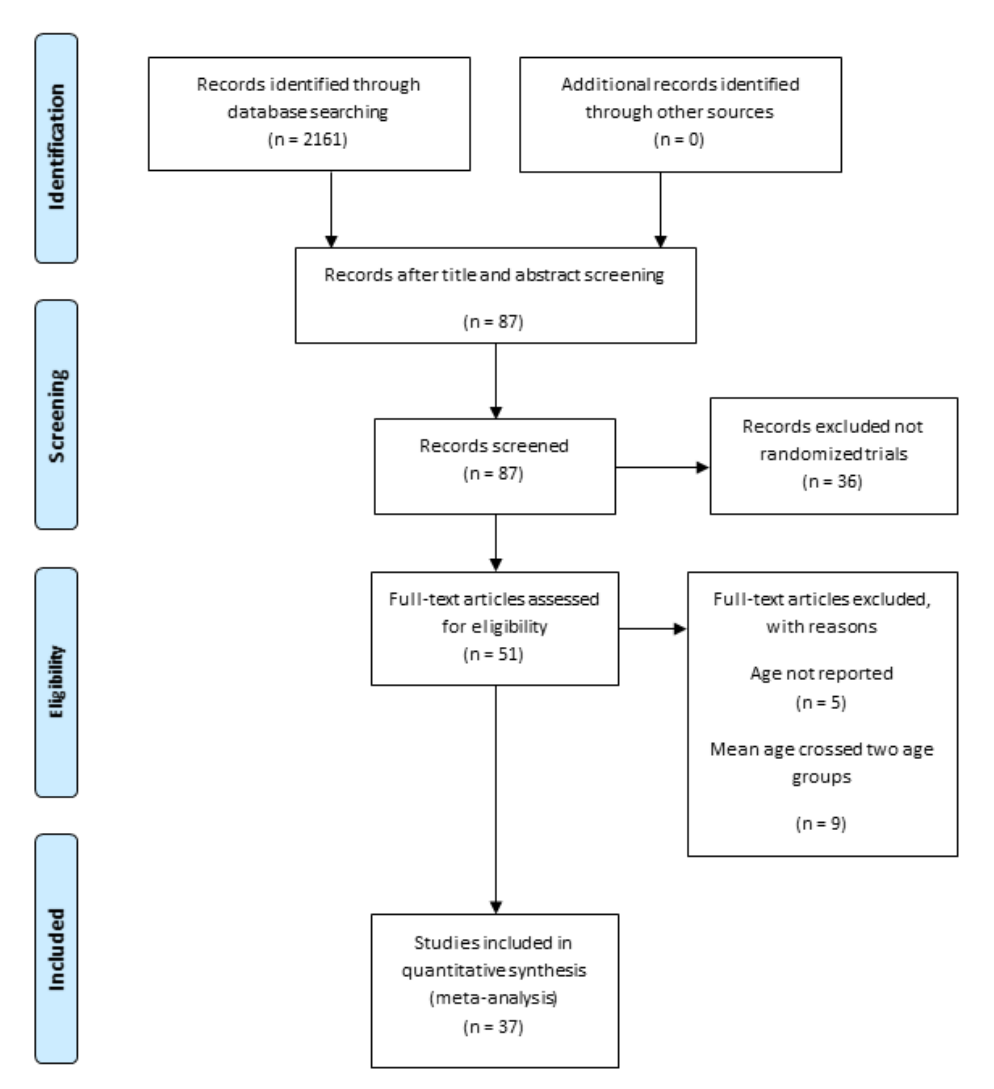
Fig. 1 – Consort figure. A flow diagram showing how the initial search results were refined until a group of studies that met all the inclusion criteria were